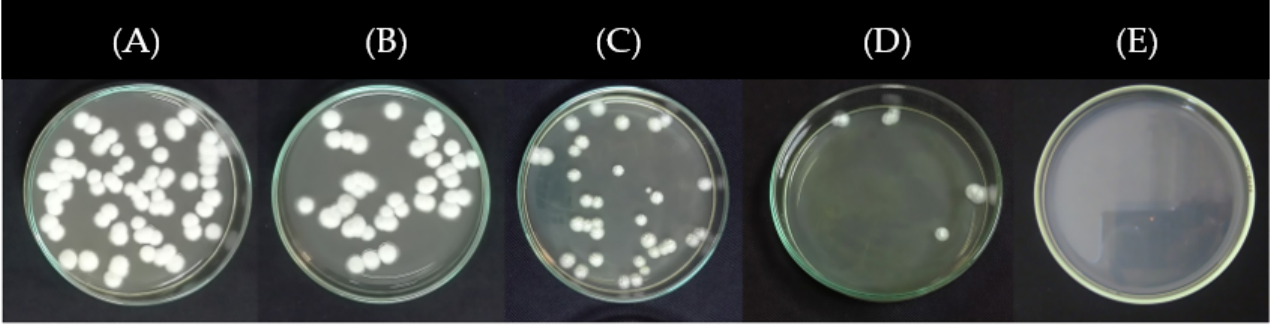
Figure 6. Effect of propolis extracts LR16 at 0% ( A ), 0.005% ( B ), 0.01% ( C ), 0.05% ( D ), and 0.1% ( E ) on the germination of Phlyctema vagabunda (CP13 isolate) conidia. The cultures were incubated at 20 °C for 4 days.